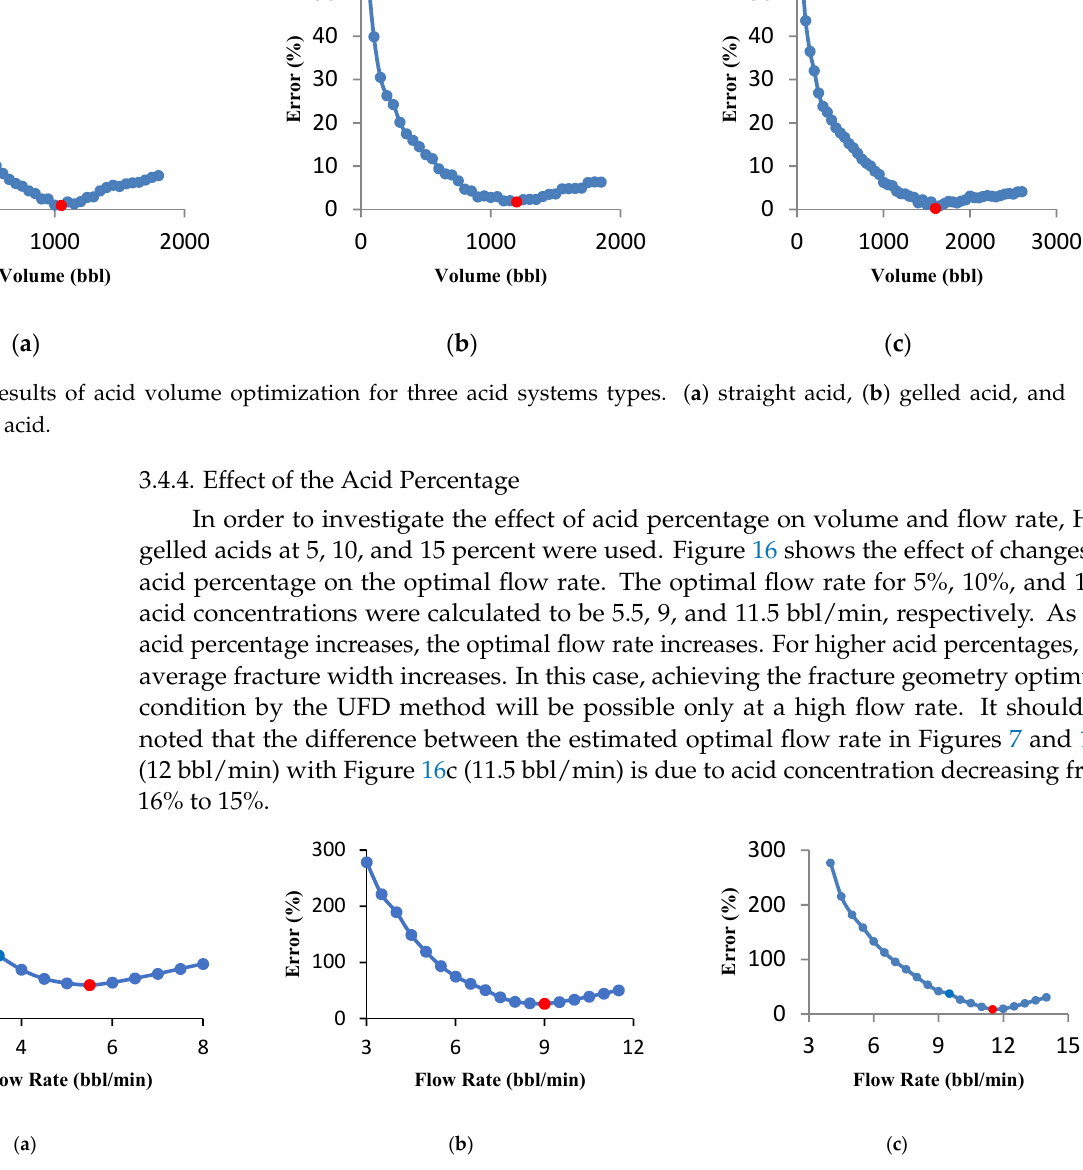
Figure 16. The effect of acid concentration on the flow rate optimization results for a 540 bbl acid volume. ( a ) 5 wt % acid, ( b ) 10 wt % acid, and ( c ) 15 wt % acid.